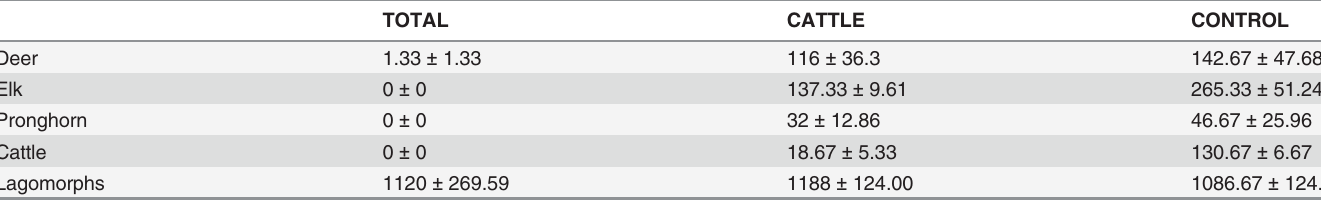
Mean densities (# per ha) ± 1 SE for pellet groups by species across three herbivore treatments: 1) Total exclosure plots that exclude both cattle and wild ungulates, 2) Cattle exclosure plots that exclude only cattle, and 3) Control plots where no large herbivores are